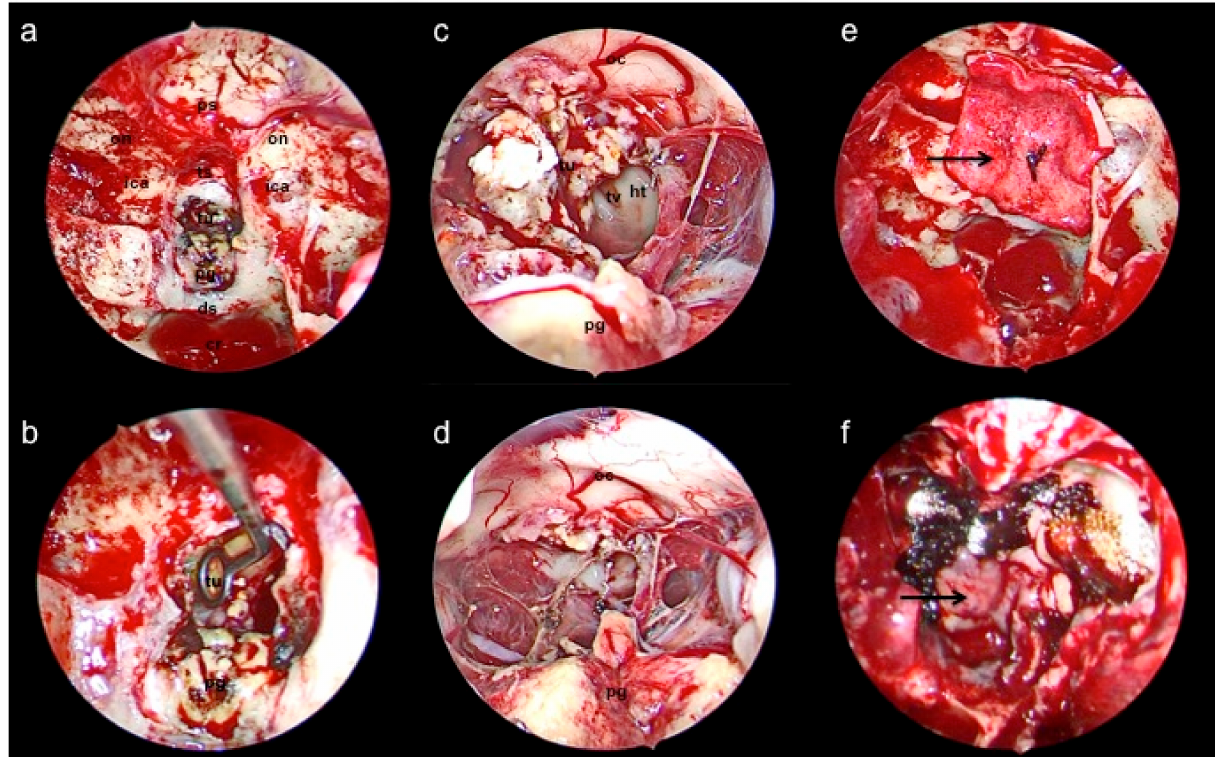
Figure 2. Intra-operative images from the endoscopic endonasal approach. ( a ) An expanded view after craniotomy and dural opening reveals relevant anatomy, followed by ( b ) a close-up view illus- trating use of an angled curette for tumor resection. The anatomy of nearby critical neural structures is shown after ( c ) tumor debulking, followed by ( d ) gross total resection. ( e ) The button double-layer closure technique with an acellular dermal matrix (arrow) is shown ( f ) reinforced with nasoseptal flap (arrow) coverage that is postage-stamped with absorbable hemostatic agents. Abbreviations: cr (clival recess), ds (dorsum sphenoidale), ht (hypothalamus), ica (internal carotid artery), oc (optic chiasm), on (optic nerve), pg (pituitary gland), ps (planum sphenoidale), ts (tuberculum sphenoidale), tu (tumor), tv (third